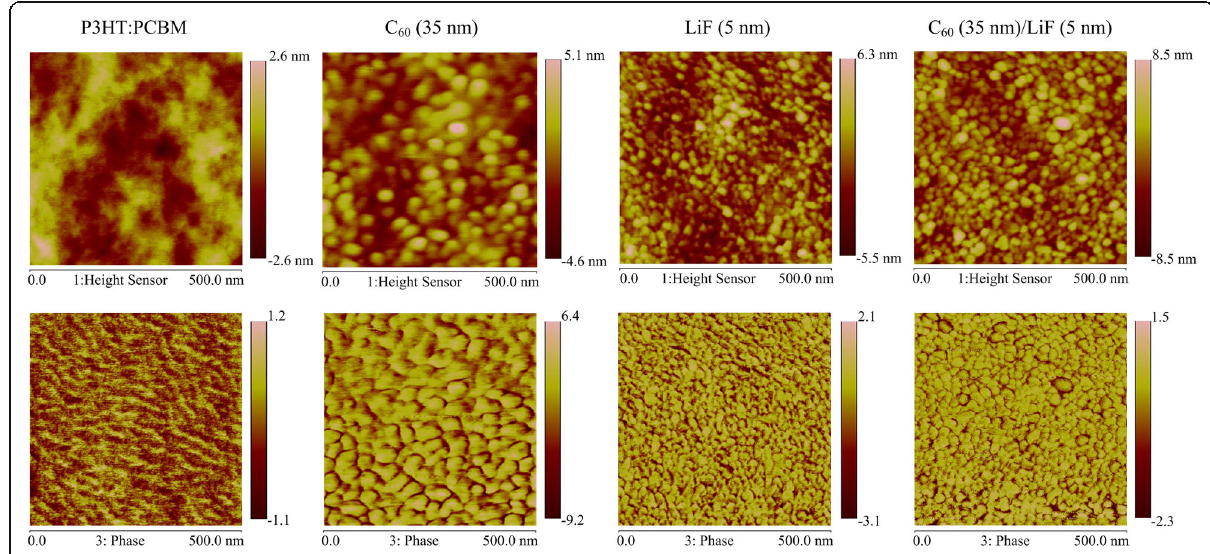
Fig. 2 Tapping mode AFM height (top) and phase (bottom) images of P3HT:PCBM, P3HT:PCBM/C 60 (35 nm), P3HT:PCBM/LiF (5 nm), and P3HT:PCBM/C